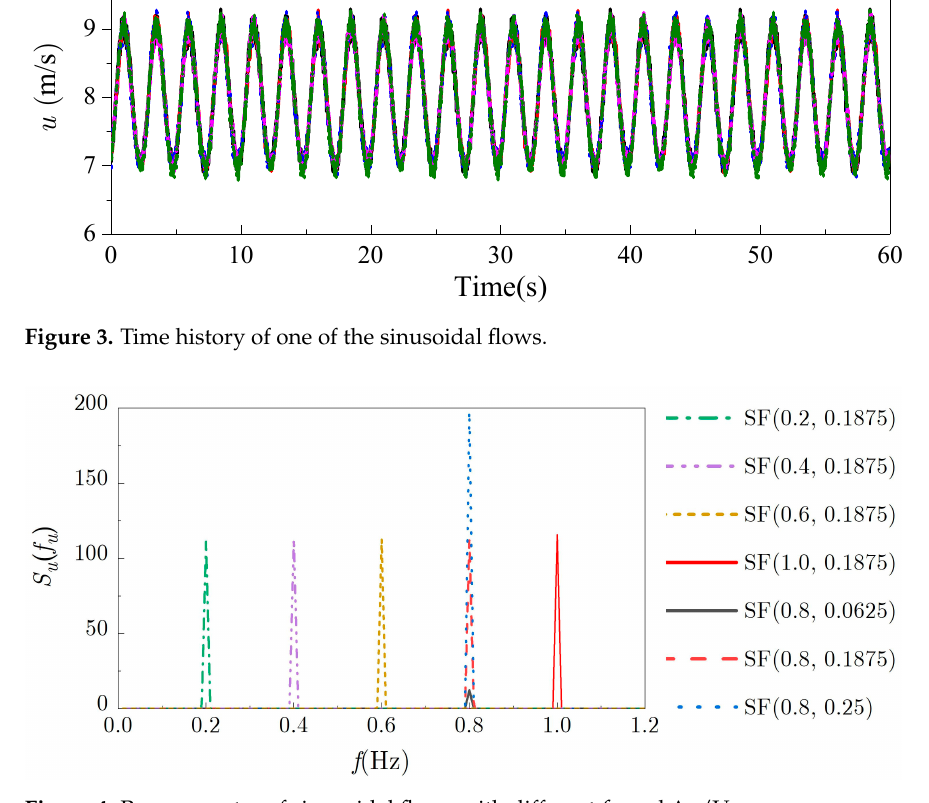
Figure 4. Power spectra of sinusoidal flows with different f u and Δ u /U.